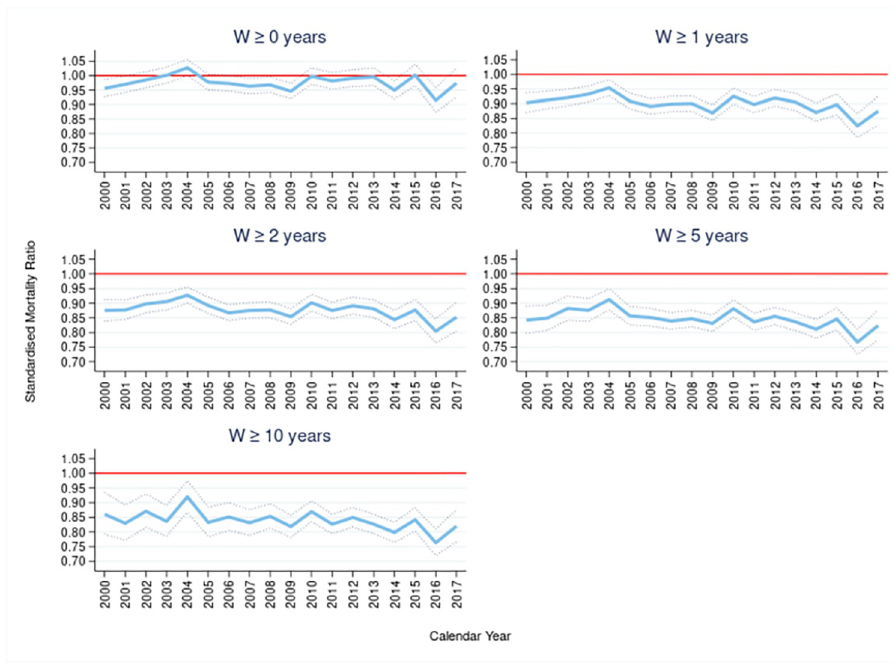
Fig 3. Standardised mortality ratio (SMR) and 95% confidence intervals by sub-cohorts selected by a minimum lookback window W � w , over calendar year. Reference line of SMR = 1 in